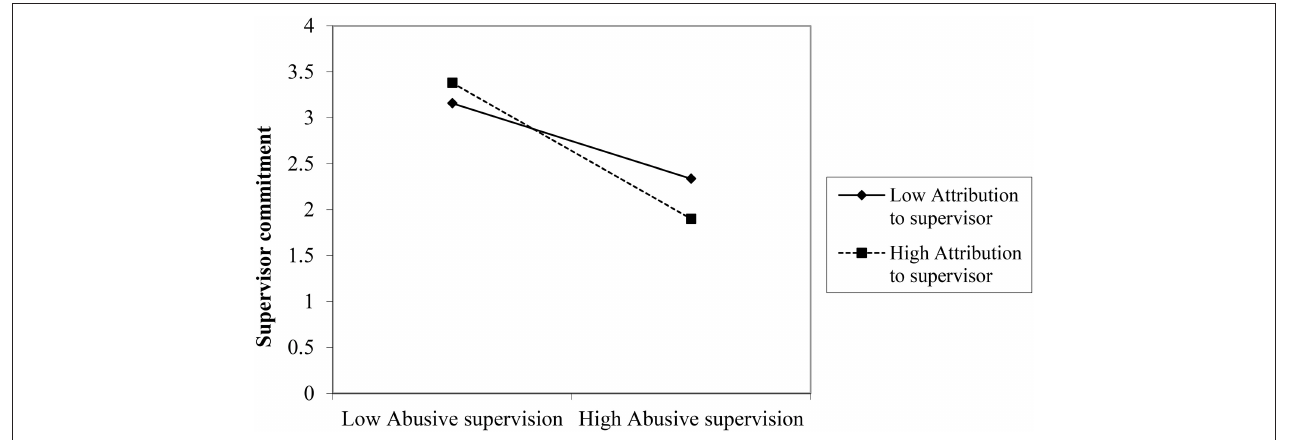
FIGURE 8 | Interaction between abusive supervision and attribution to the supervisor on supervisor commitment (Study